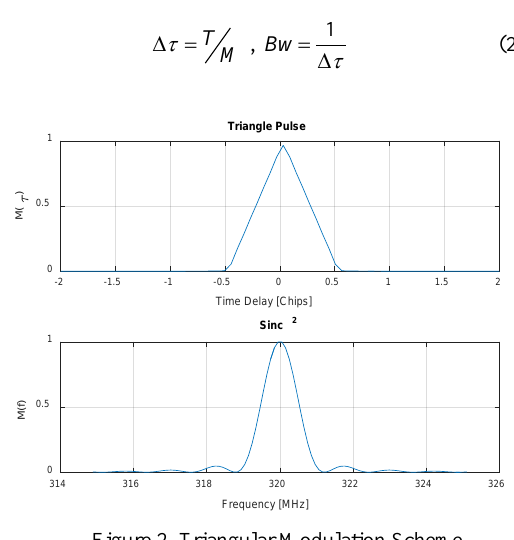
Figure 2. Triangular Modulation